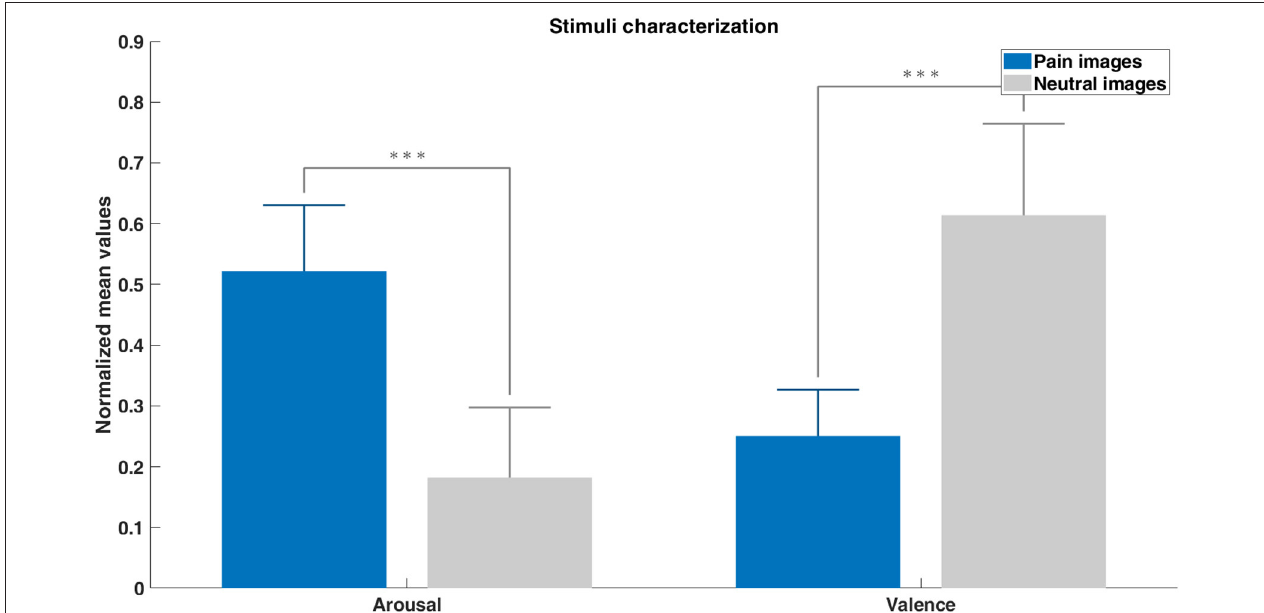
FIGURE 5 | Pain and neutral images characterization based on the arousal and valence ratings given by an independent group of subjects (feature scaled mean values + SE). Differences between pain and neutral stimuli were assessed with unpaired t -tests (*** p < 0.001).